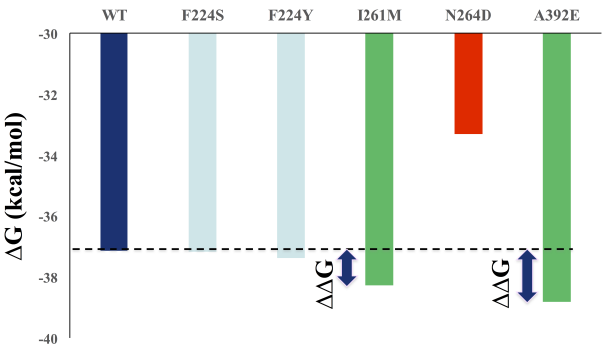
Figure 10. Comparison of binding free-energy values of ligand 2h against WT and mutants.